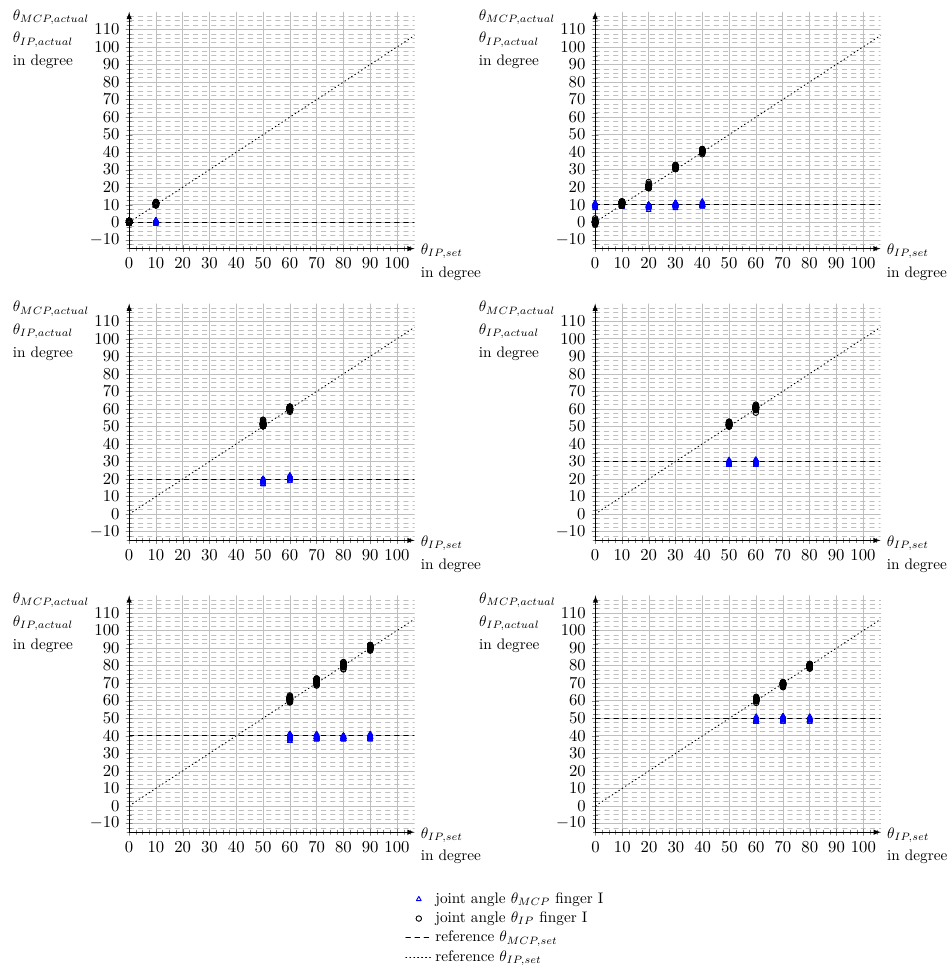
Figure A4. Accuracy of measurement for finger I. Joint angles θ set for the Metacarpophalangeal (MCP) joint from θ MCP , set = 0° to θ MCP , set = 50° and for the Interphalangeal (IP) joint θ IP , set . Joint angles θ MCP , actual and θ IP , actual measured with